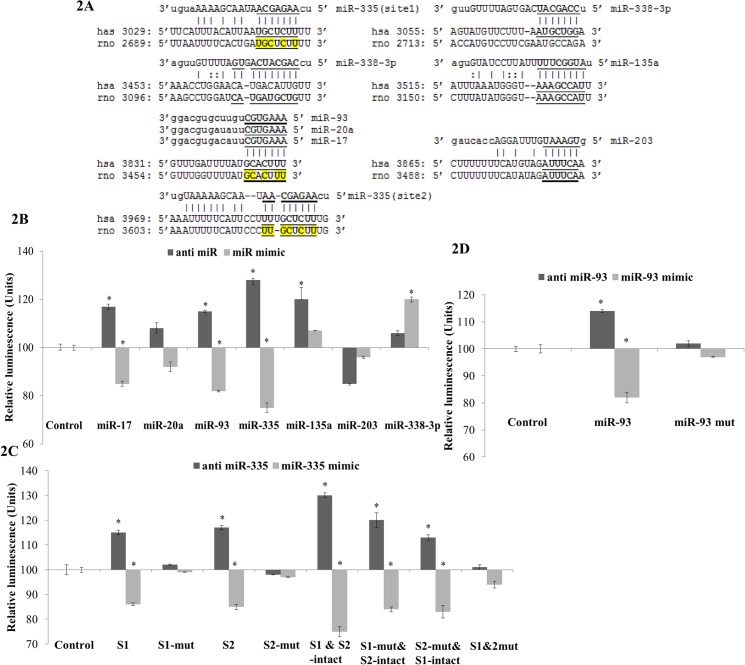
3'UTR sequence of the HIF-1α gene for both rat and human and Dual Luciferase assay for selected miRNAs predicted targeting Hif-1α.(A) The sequences were retrieved from NCBI GenBank Database (hsa NM_001530.3 and rno NM_024359.1). The predicted binding site(s) of selected miRNAs (miRNA-17, -20a, -135a, -203, -335, -338-3p and -93) to the 3'UTR of Hif-1α is mapped in this figure. The miRNA seed regions are marked in bold and underlined. Nucleotides which were altered for mutational studies are marked in yellow colour. (B) Quantitation of the effects of anti miRNAs and miRNA mimics (including miR-17, -20a, -135a, -203, -335, -338-3p and -93) interaction with the 3' UTR of Hif-1α. (C) Quantitation of the effects of anti miR-335 and miR-335 mimic interactions with the normal binding sites and mutated binding sites in 3' UTR of Hif-1α. S1 and S2 denoted site 1 and 2 respectively. (D) Quantitation of the effects of anti miR-93 and miR-93 mimic interactions with the normal binding sites and mutated binding sites in 3' UTR of Hif-1α. The plasmid constructs together with anti miRNAs and miRNA mimics were co-transfected into HeLa cells. Luminescence for luciferase gene activity in treated samples (anti miRNAs and miRNA mimics) was obtained 48 hrs post-transfection. Relative luminescence was obtained by normalizing the values against control plasmids, pMIR-REPORT without any 3'UTR insert. Data presented as mean ± SD with n = 3. Statistically significant differences are tested at p value < 0.05 significance. *p value < 0.05.